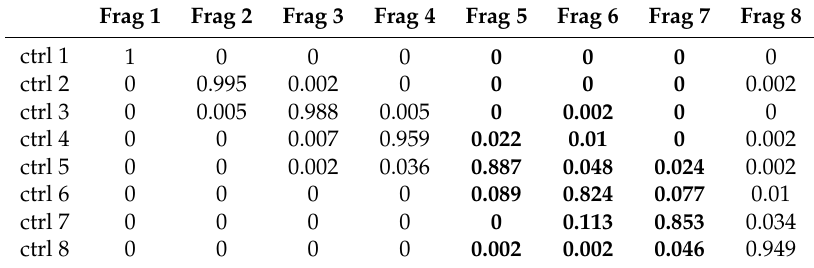
Table 2. Normalized confusion matrix of PCA for the 8 independent leads from ECG. The ij value of the table represent the ratio of i -th component of control patient that is paired with the j -th component of synthetically fragmented patient according to the value of